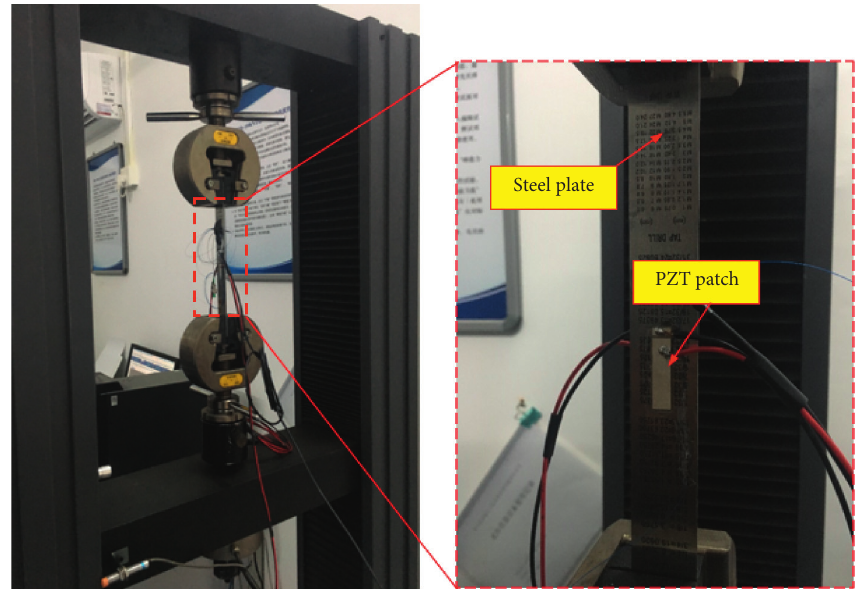
Figure 4: Experimental setup for tensioning the steel